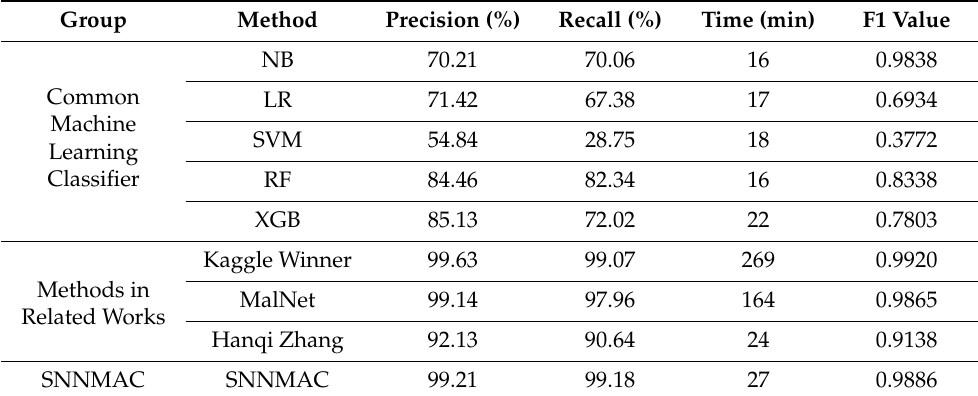
Table 6. The results of the comparative